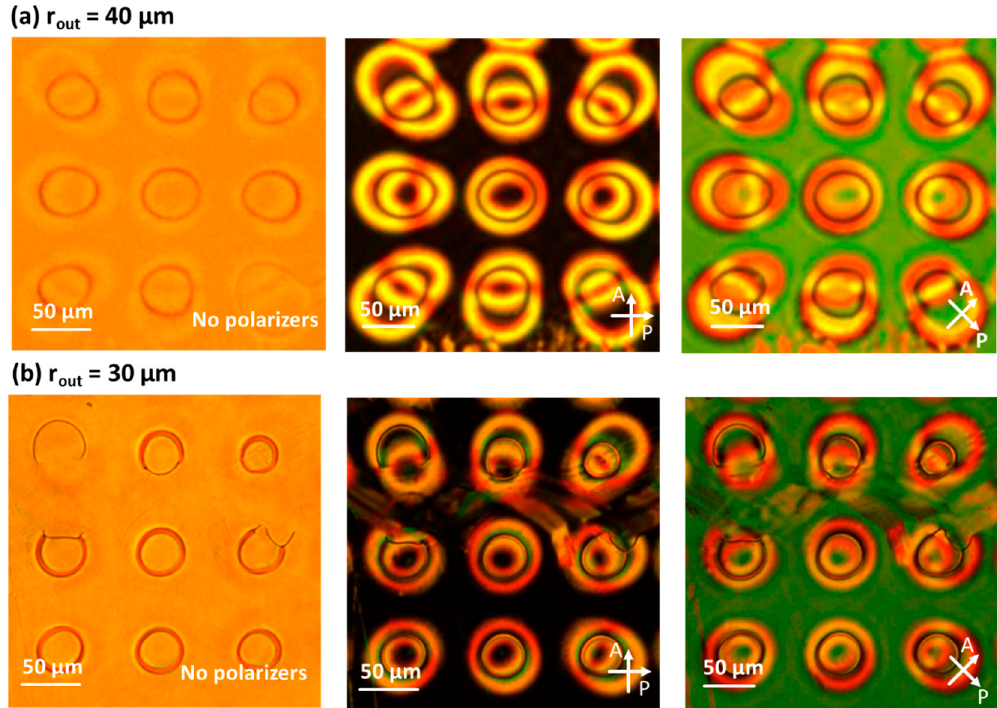
Figure 6. Microscope images in a region of the cell with dimensions of the patterned rings r out = 40 µm ( a ) and r out = 30 µm ( b ) respectively (r in = 0.4 * r out ). The transmission is show without polarizers present (left), for crossed polarizers aligned with x- and y-axis (middle) and for crossed polarizers rotated over 45° with respect to the x- and y-axis (right).